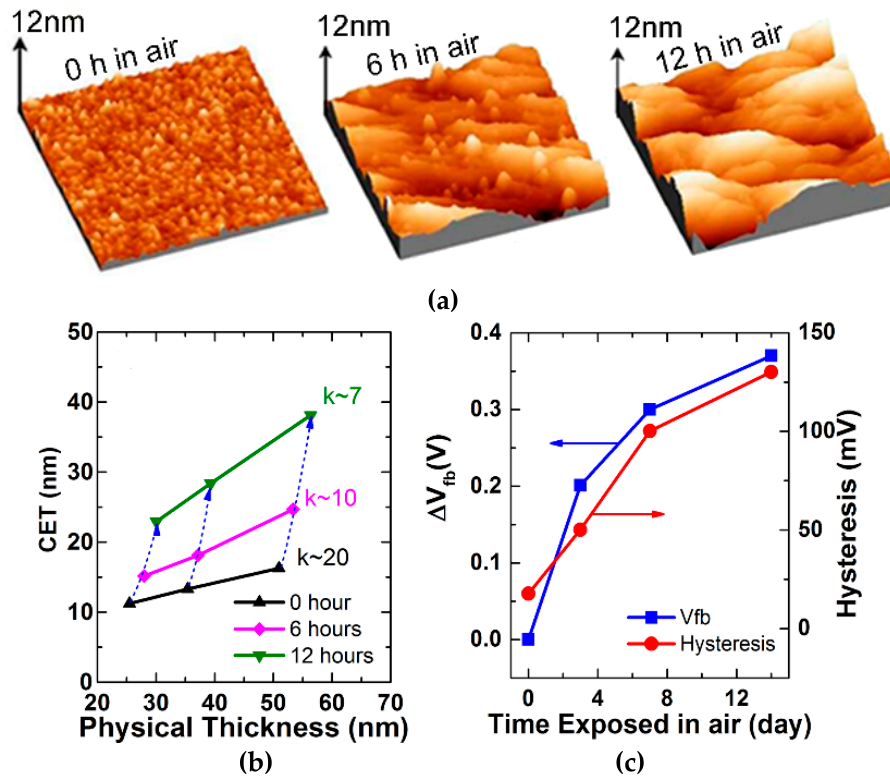
Figure 5. Impact of the hygroscopicity of La 2 O 3 on ( a ) surface roughness, ( b ) film thickness and k value, and ( c ) V fb and hysteresis of an MOS device [37].